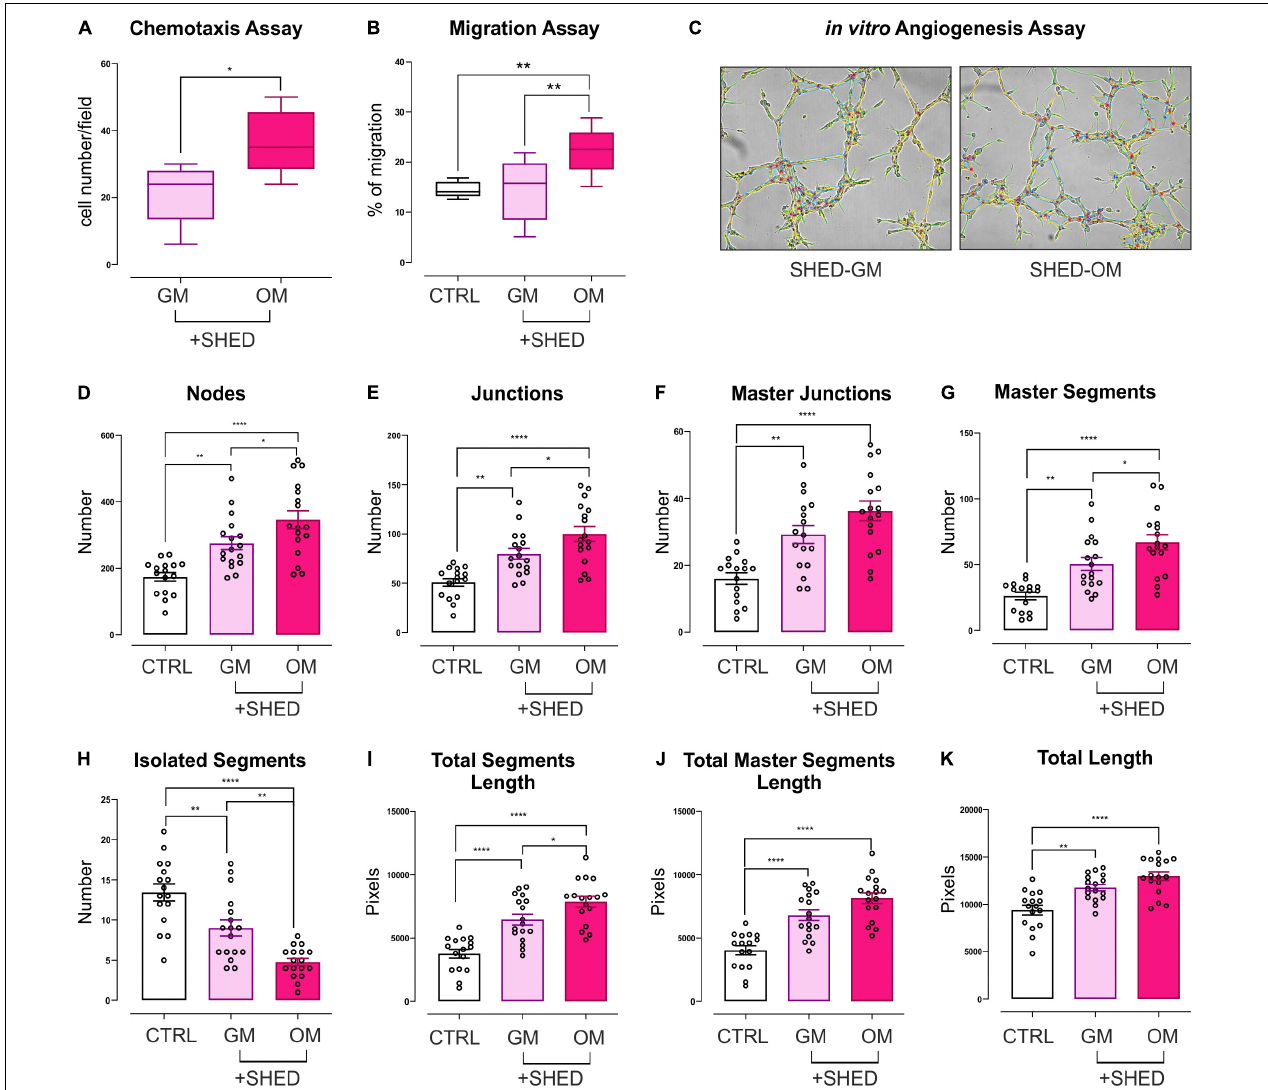
FIGURE 3 | Evaluation of the angiogenic potential of HMEC conditioned by SHED. (A) Chemotaxis assay performed on HMEC cocultured with SHED-GM or SHED-OM. Data represent Min to Max; n = 5. * p < 0.05. Statistical analysis: unpaired non-parametric Mann Whitney test. (B) Migration assay performed on HMEC alone or cocultured with SHED-GM or SHED-OM. Data represent Min to Max; n = 12. ** p < 0.01. Statistical analysis: ordinary one-way ANOVA with Tukey’s multiple comparisons test. (C) Representative pictures of in vitro tubulogenesis assay performed on HMEC cocultured with SHED-GM or SHED-OM. (D–K) The formation of capillary-like structures was performed on Matrigel coating and analyzed after 8 h using ImageJ’s Angiogenesis Analyzer tool. Data represent MEAN ± SEM; n = 17. * p < 0.05; ** p < 0.01; **** p < 0.0001. Statistical analysis: ordinary one-way ANOVA with Tukey’s multiple comparisons